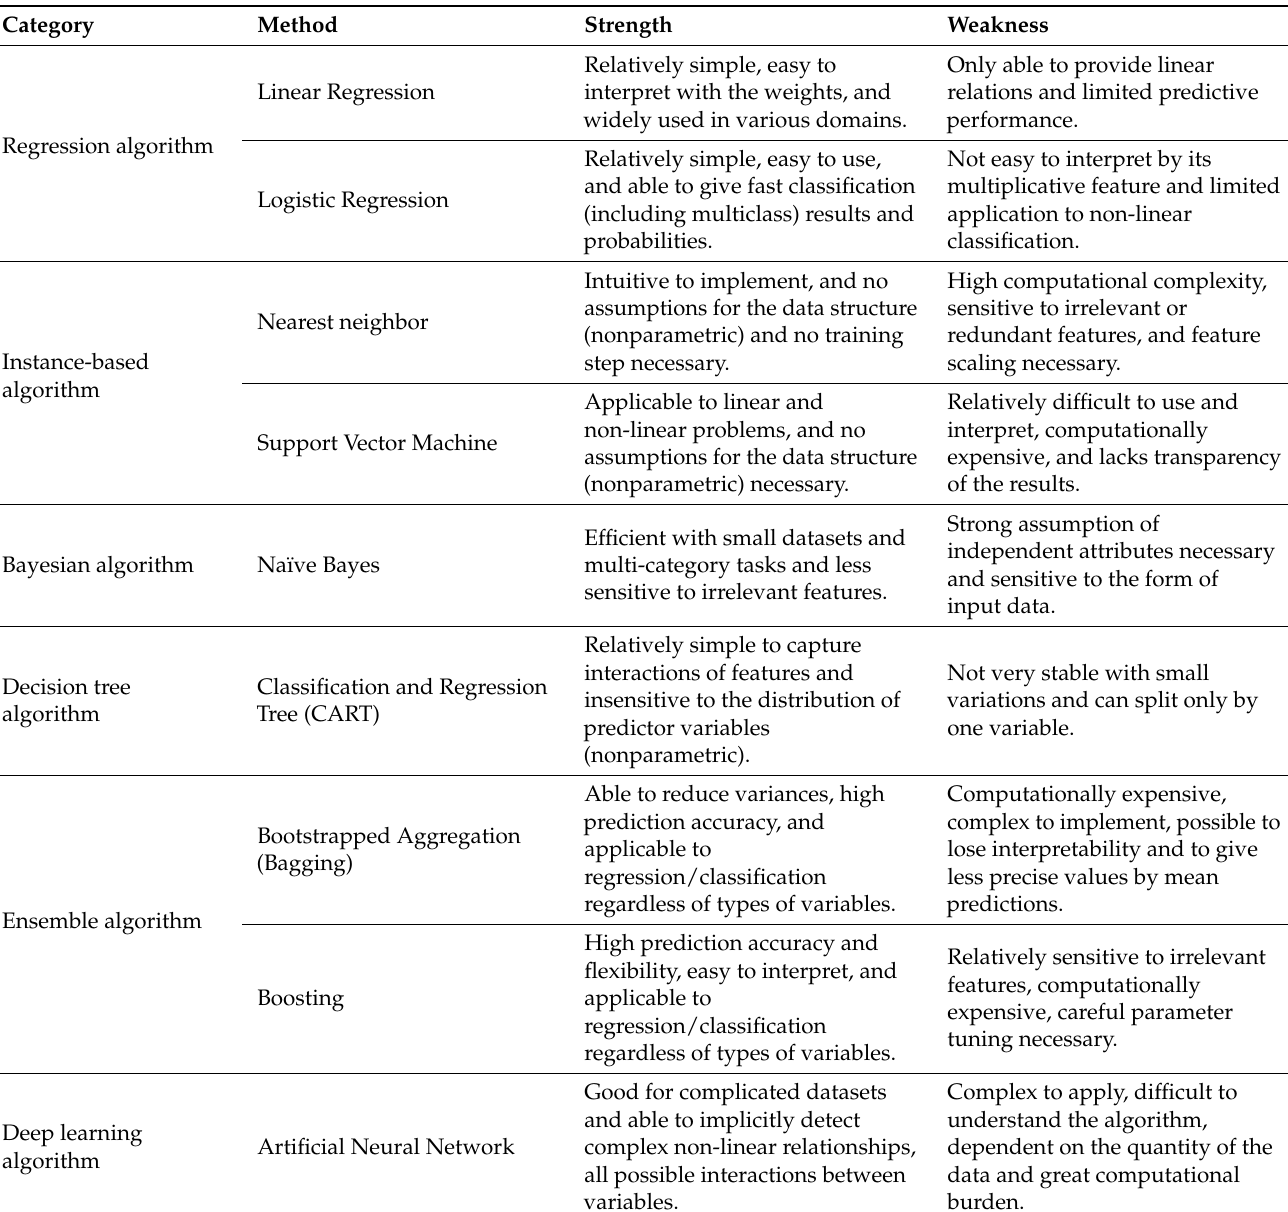
Table 3. Possible methods for